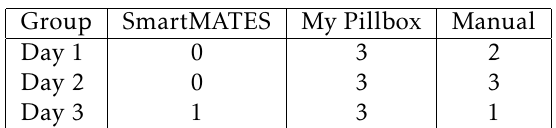
Table 1. Medicine Adherance for 3 days Group SmartMATES